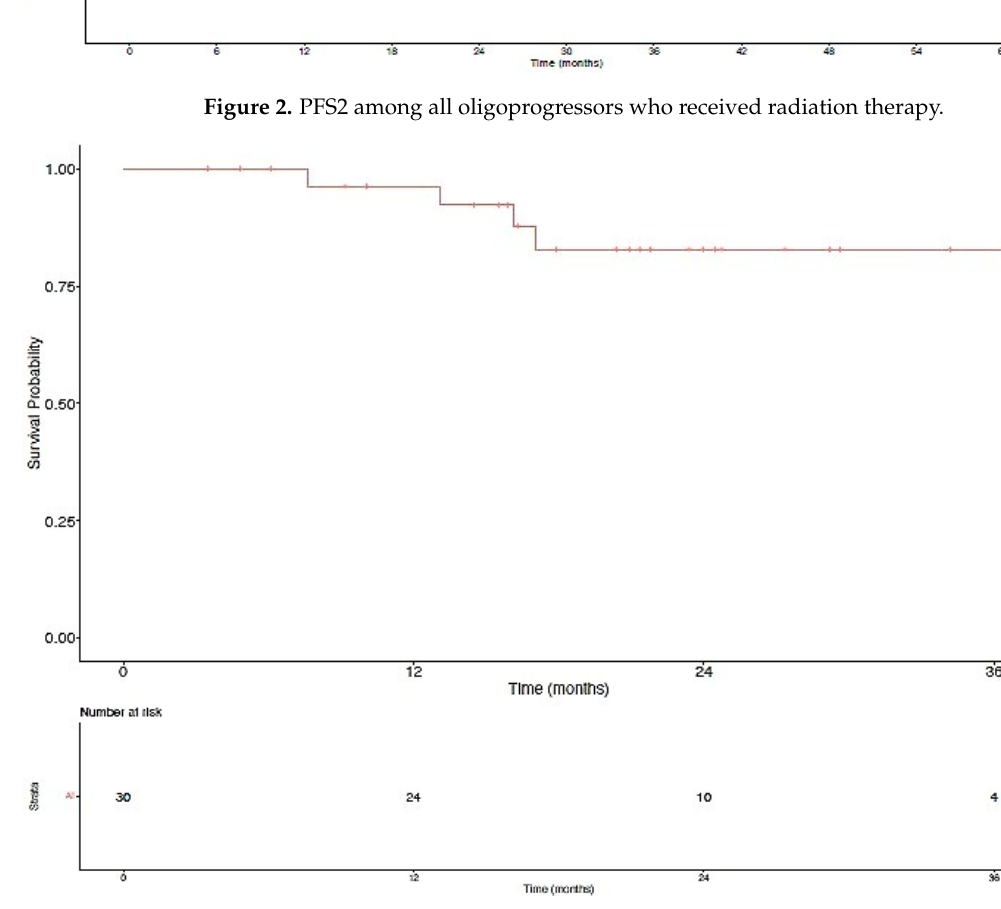
Figure 3. OS among all oligoprogressors who received radiation therapy. Seventeen of the thirty patients (56.7%) who received radiation therapy subsequently progressed, with a median time to second progression of 8.6 months (range 4.6–19.4 months) after completing treatment. Five of these patients progressed within six months of completing radiation therapy. Six patients progressed at a single site, four at two sites, five at three sites, and two at four or more sites. The most common sites of second pro- gression included the liver (14 sites, 7 patients) and lymph nodes (13 sites, 8 patients). 14/17 patients (82.4%) who progressed after receiving radiation therapy did so at a sepa- rate site, eight of whom subsequently received radiation therapy to the new site of disease progression; only three of the seventeen patients (17.6%) progressed at a treated site. Local control at treated, oligoprogressive sites at 6, 12, and 24 months was 96.7%, 82.9%, and 82.9%, respectively (Figure 4). More information on each patient in this cohort may be found in the supplementary Table S1.